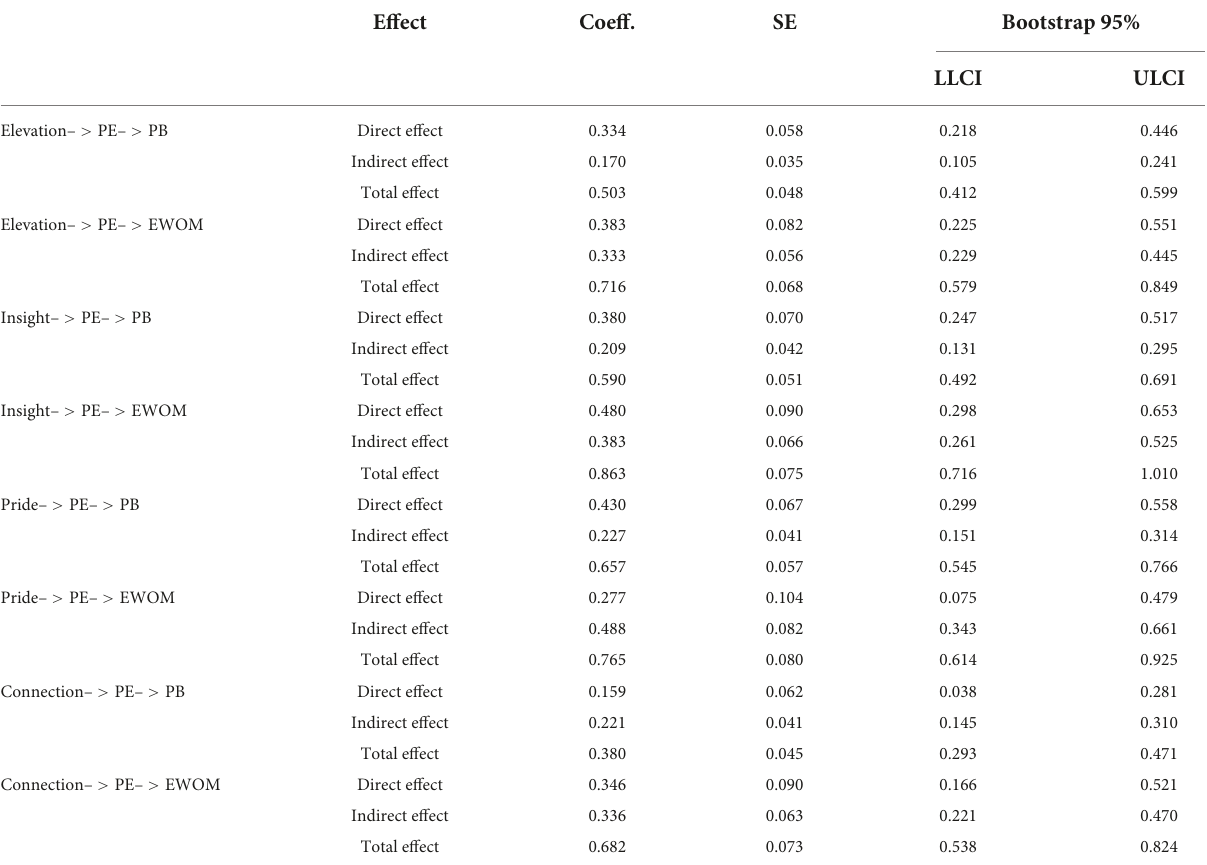
TABLE 11 Results of the mediating